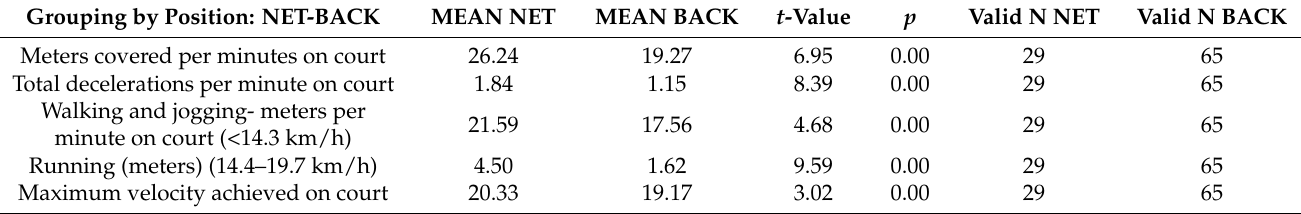
Table 3. Using a T-test for independent samples between groups of ball kids on net and back posi- tions, the analyzed variables are meters covered per minute on court, total decelerations per mi- nute on court, walking and jogging meters per minute (< 14.3 km/h) and maximum achieved ve- locity on court.